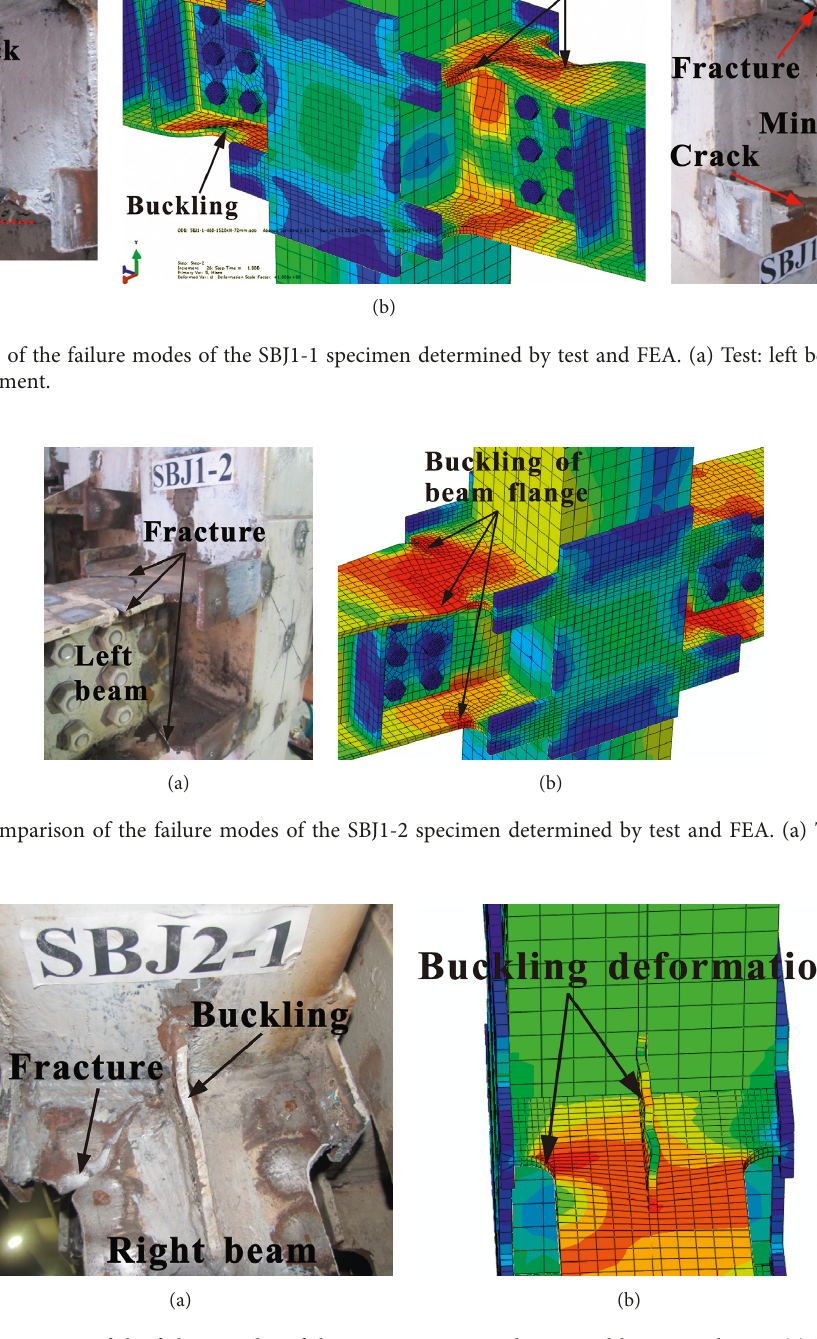
Figure 12: Comparison of the failure modes of the SBJ2-1 specimen determined by test and FEA. (a) Test. (b) FEA.